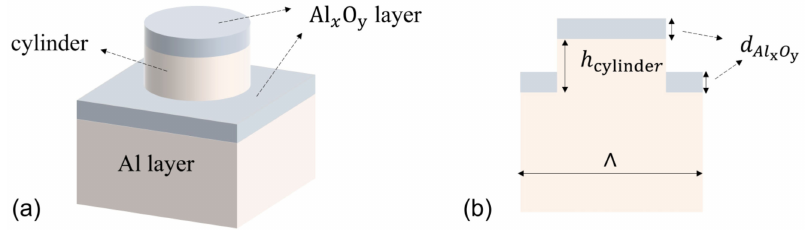
Figure 5. ( a ) Surface element of the native alumina-coated model surface; ( b ) the same in cross